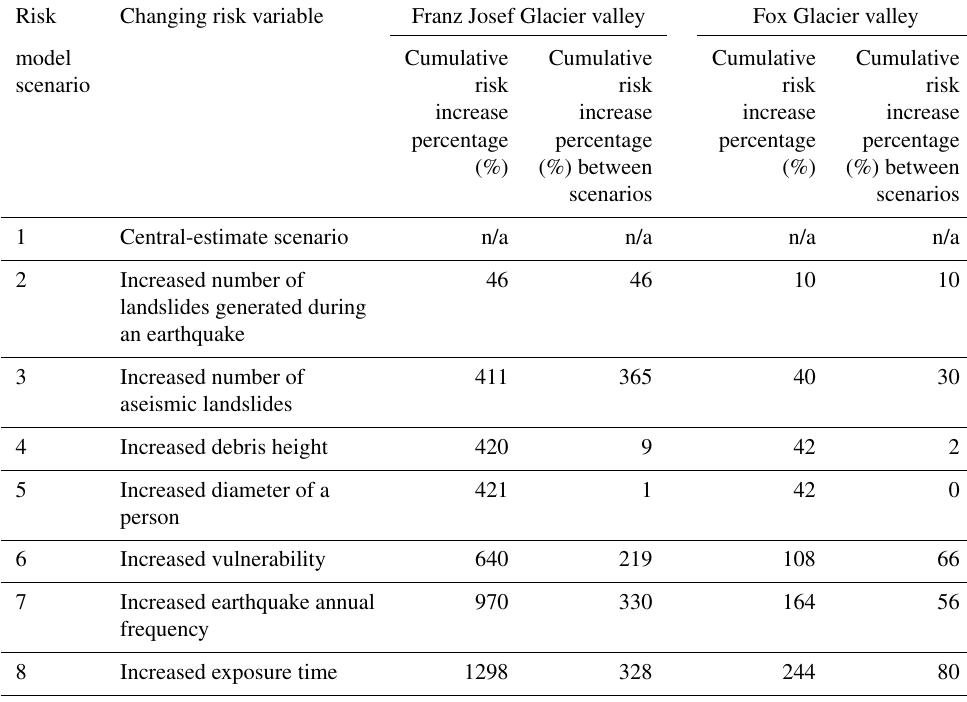
Table 3. Risk model sensitivity analysis displaying the factor in increased risk between each scenario and the cumulative increase in risk from the central to upper estimate (Scenario 8).